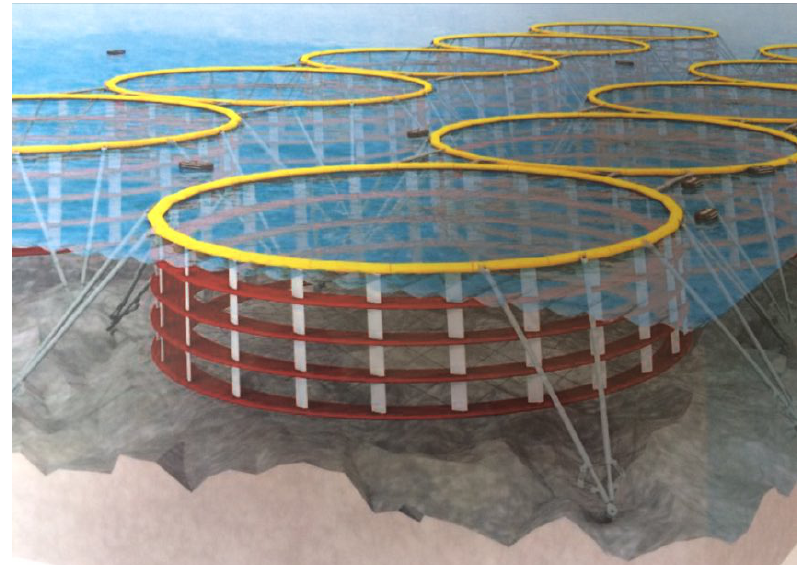
Figure 15. Bearingless vertical axis tidal turbine array by Salter. Source: [99].